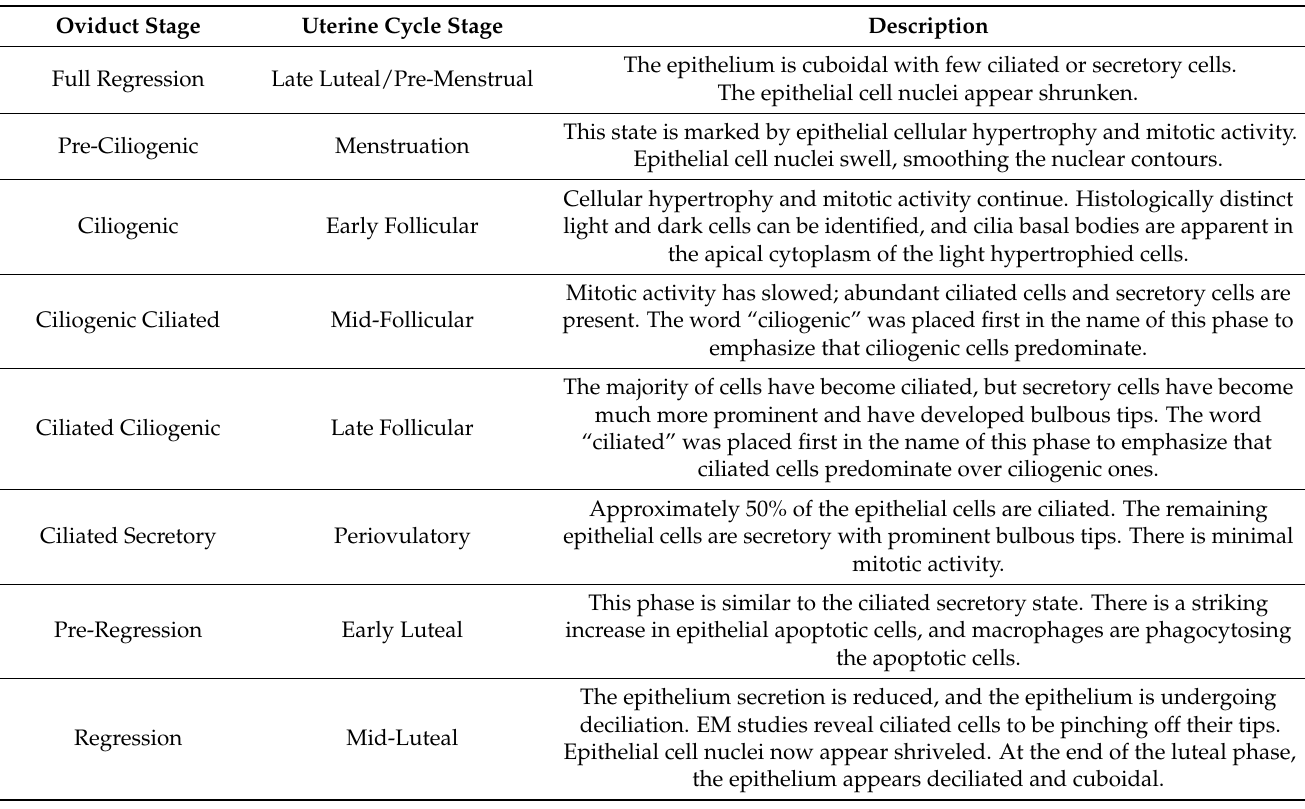
Table 1. Cyclic stages of the oviductal fimbria in